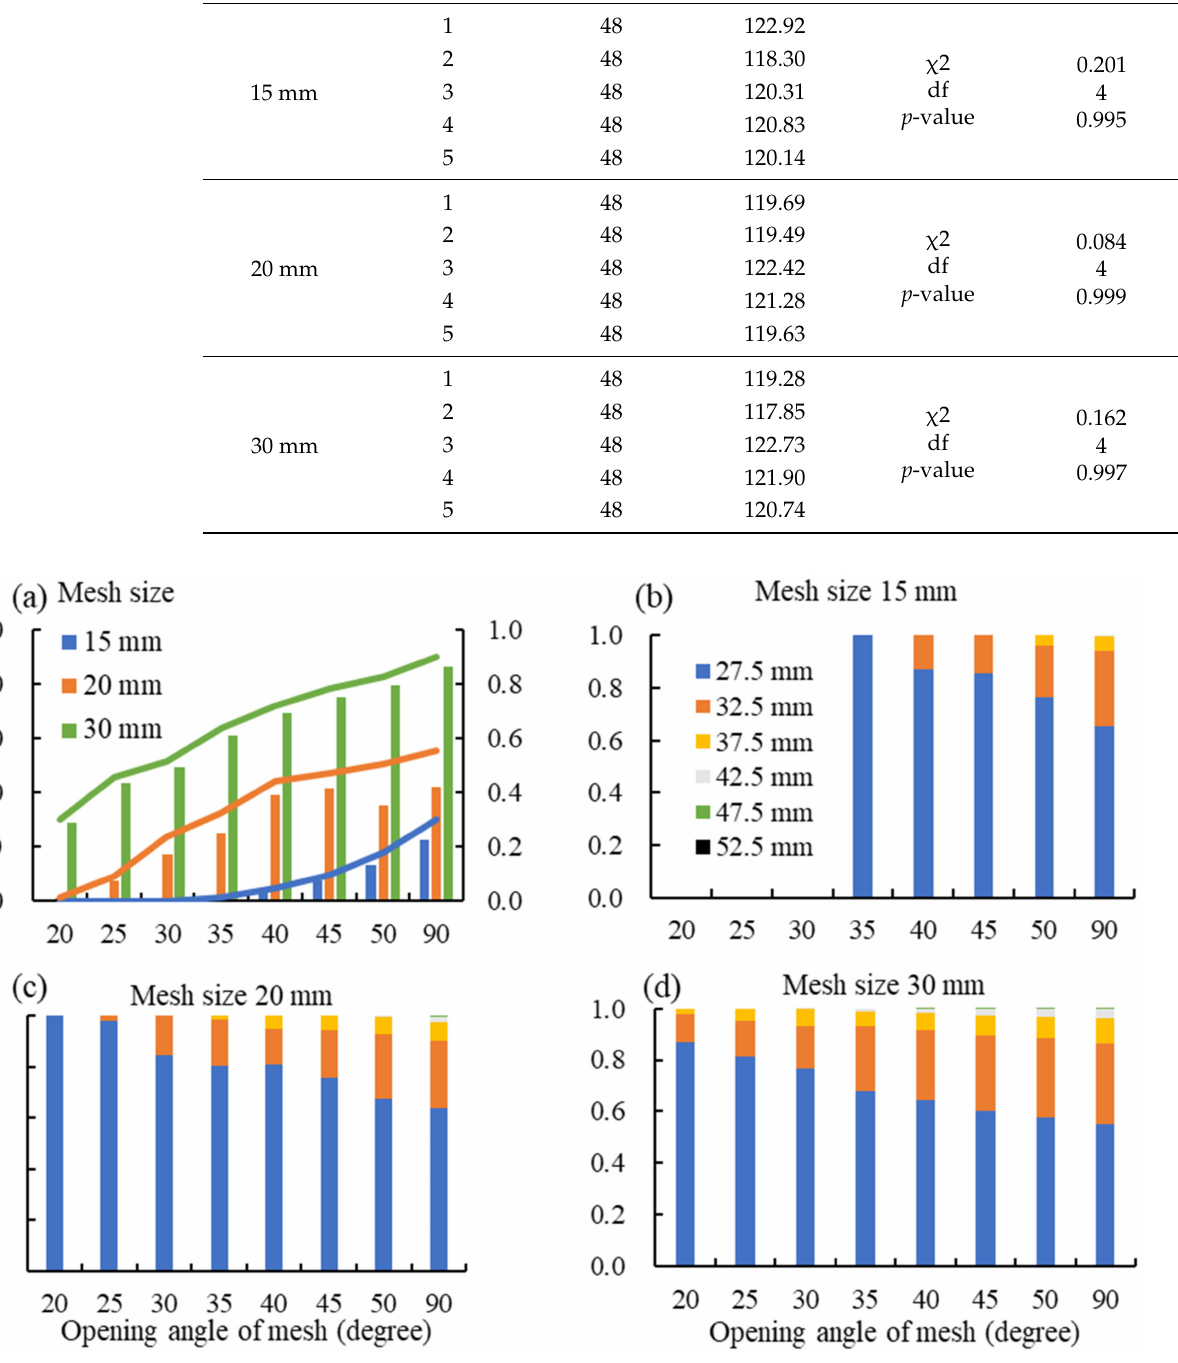
Figure 4. Dynamics of the abundance of captured krill (y-axis) as a function of the mesh opening angle (x-axis). ( a ): Number of krill in the collection bag (Columnar) and the proportion of total number of krill for the test (line); ( b – d ): Length frequencies of krill in the collection bag associated with different mesh opening angles for mesh sizes 15 mm, 20 mm, and 30 mm,